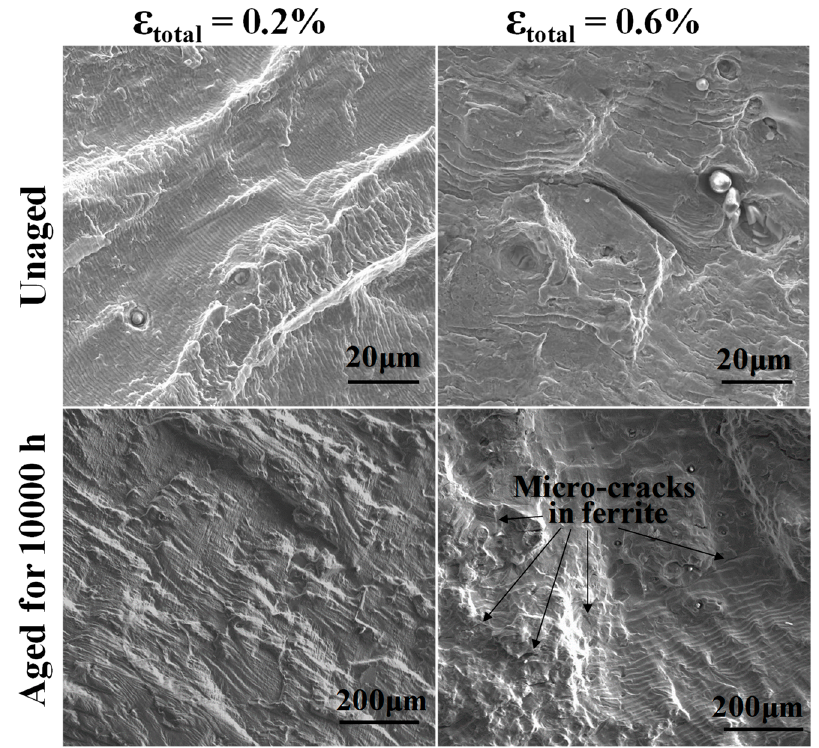
Figure 4. The morphologies of the fatigue crack growth regions in the unaged and aged CDSS under different strain amplitudes.